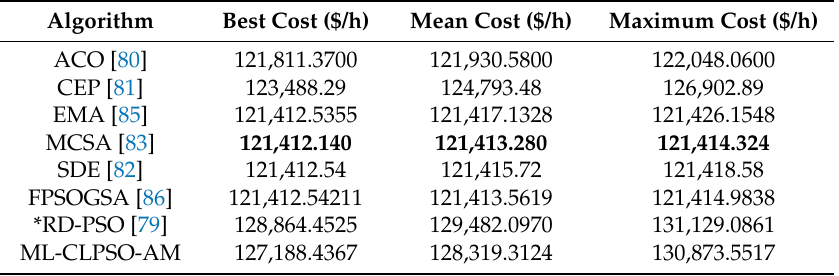
Table 10. Comparison test results on a 40-unit